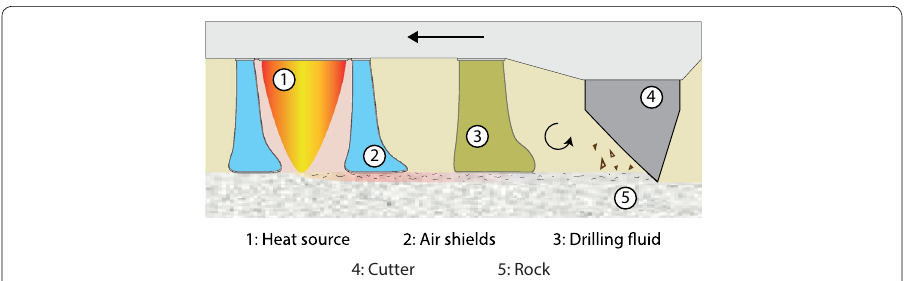
Fig. 1 Combined thermo–mechanical drilling. The combined thermo–mechanical drilling (CTMD) concept is based on thermally weakening the material prior to mechanical removal. The heat source (1), is protected by air shields (2) in the drilling fluid (3) environment at the drill bit. This allows the heat to reach the rock surface and thermally treat the material, which is then rapidly cooled down by the drilling fluid. Thereby, the weakened rock is finally removed by the cutter (4) which penetrates and drills the rock (5) with reduced effort. The drill bit moves from right to left in this